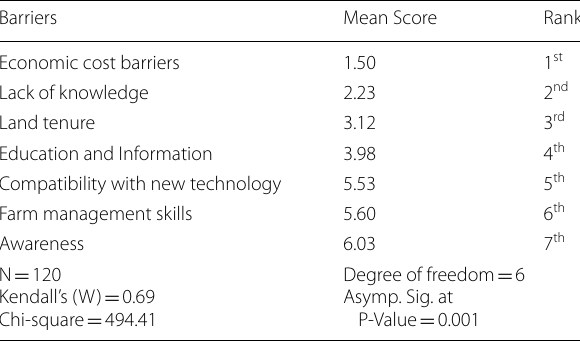
Table 7 Ranking of barriers in adopting sustainable